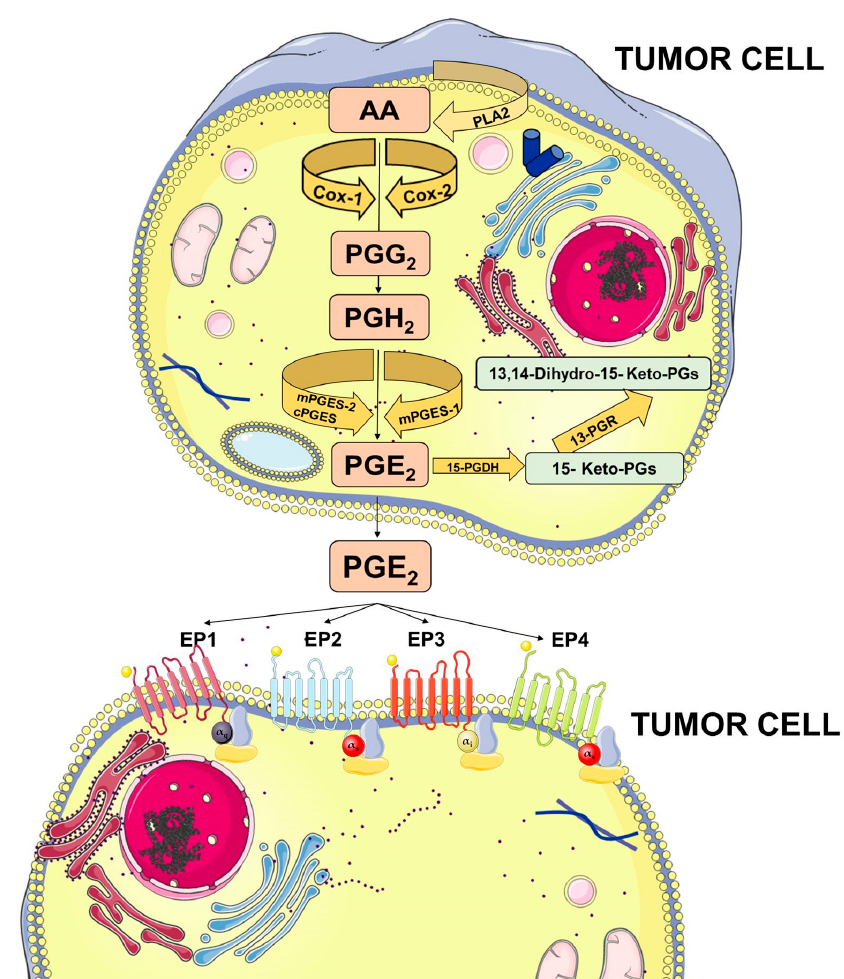
Figure 1. Prostaglandin E2 (PGE2) biosynthesis. Arachidonic acid (AA) is a polyunsaturated fatty acid that constitutes the phospholipid domain of most cell membranes and is released from the cellular membranes by cytoplasmic phospholipases A2 (PLA2). Free AA can be metabolized to PGE2 through to the intermediate prostaglandin G2 (PGG2), which is then reduced to the intermediate PGH2